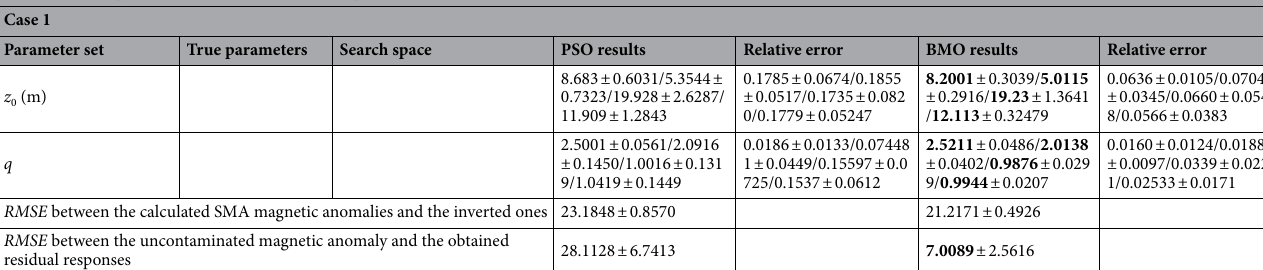
Table 3. Inversion results of the pure residual and contaminated magnetic anomaly caused by multiple- sources using BMO and PSO without and with the implementation of the SMA technique. The order of source structures is as in Table 2. Significant values are in bold.